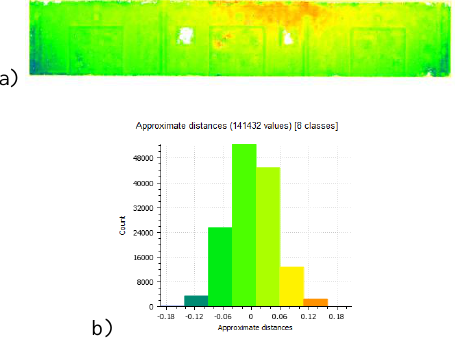
Figure 14. Accuracy assessment of a point cloud generated from video frames with a 90% overlap, with reference to a point cloud from NIKON D800 data a) in graphical form and b) as a